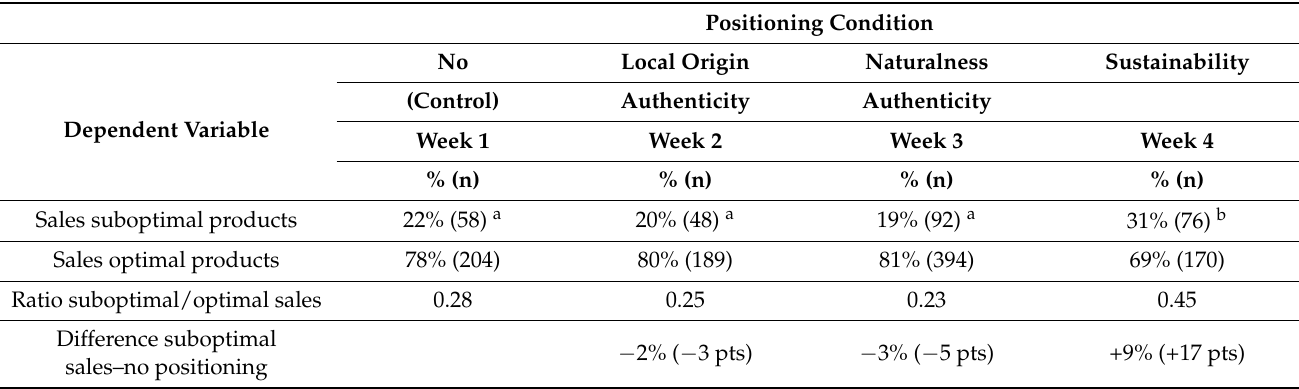
Table 1. Suboptimal and Optimal Product Sales (in kg) as a function of Positioning Strategy in Study 2. Positioning